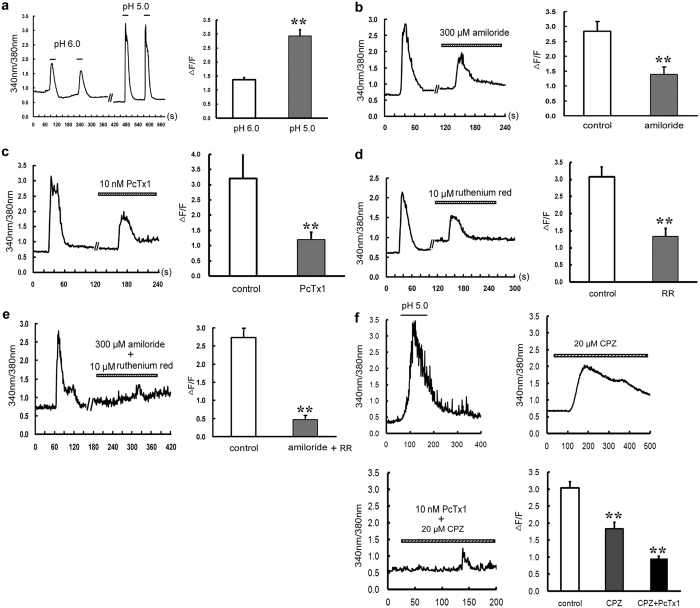
Inhibitory effect of ASIC and TRPV1 inhibitors on extracellular acid solution-induced [Ca2+]i elevation in cultured rat ventricular cardiomyocytes.(a) Representative [Ca2+]i responses and quantitative analysis of normalized Fura-2/AM fluorescence induced by pH 6.0 (n = 15 cells) and pH 5.0 (n = 19 cells) solutions. Data were expressed as mean ± s.e.m (**P < 0.01 vs pH 6.0, Student’s t-test). Pretreatment with (b) Amiloride (300 μM, n = 12 cells), (c) PcTx1 (10 nM, n = 12 cells, left), (d) Ruthenium red (10 μM, n = 16 cells) or (e) Amiloride + ruthenium red (n = 10 cells) for 5 min all inhibited [Ca2+]i elevation. Data were shown as mean ± s.e.m. **P < 0.01 vs control (Student’s t-test). RR, ruthenium red. (f) Representative [Ca2+]i responses and quantitative analysis of normalized Fura-2/AM fluorescence induced by pH 5.0 solutions (n = 20 cells, control), pretreatment with CPZ (10 μM, n = 17 cells) and CPZ + PcTx1 (10 nM, n = 23 cells) for 5 min. Data were shown as mean ± s.e.m. **P < 0.01 vs control (ANOAN followed by LSD).